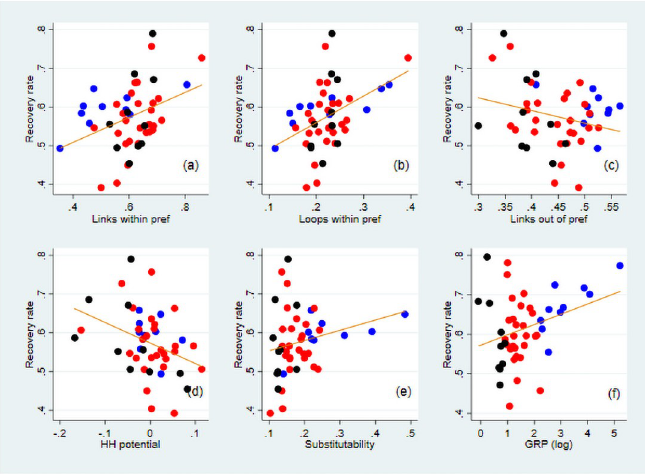
Fig 4. Correlation between the recovery rate and selected network measures. The vertical axis indicates the recovery rate, defined as the ratio of the increase in the GRP of a prefecture by lifting its own lockdown to its decrease because of the lockdown of all prefectures. Except for panel (f), the effect of GRP is excluded from the recovery rate. The horizontal axis indicates the share of the links within the prefecture to its all links in (a), the share of the loop flows within the prefecture to its total flows in (b), the share of the links to other prefectures to all links in (c), the standardised potential flows in (d), the share of substitutable suppliers to all suppliers outside the prefecture in (e), and GRP in logs in panel (f). The orange line in each panel specifies the fitted value from a linear regression that controls for the effect of GRP. The blue, black, and red dots show prefectures whose GRP is among the top 10, bottom 10, and others,